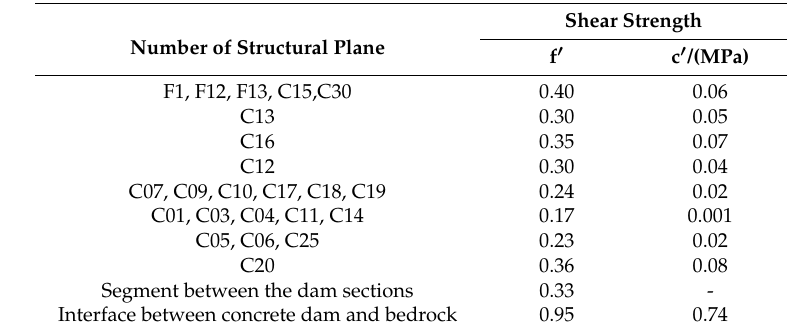
Table 3. Parameters of Structural